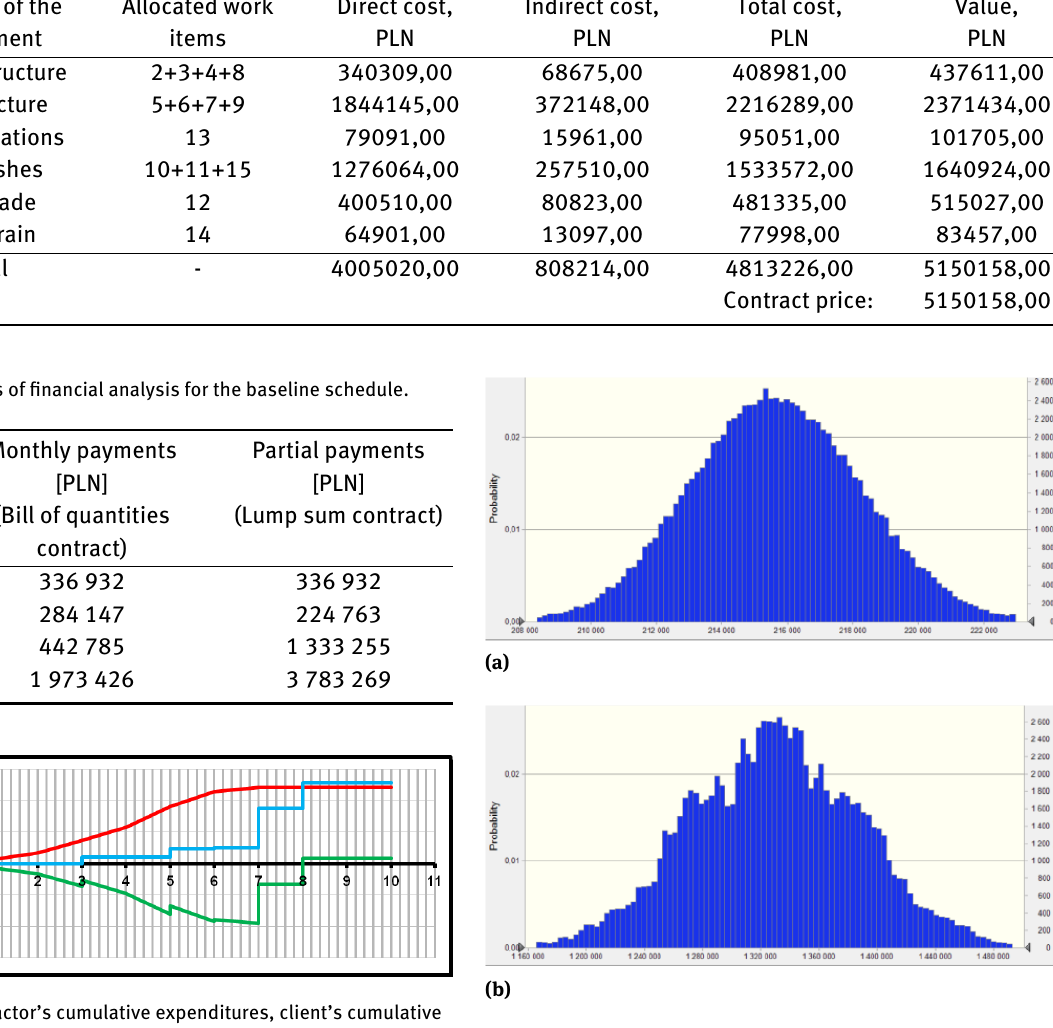
Figure 6: Sample simulation reports for the bill of quantity contract: a) project NPV , b) maximum monthly cash requirement CF max